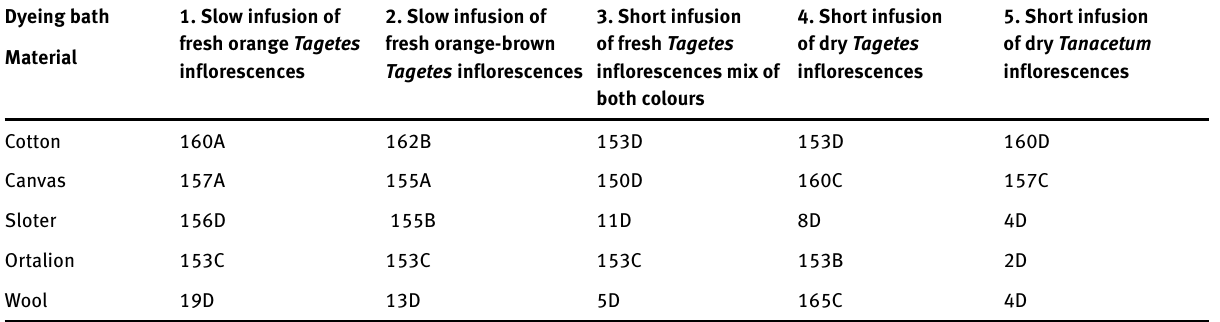
Table 4 : RHS colours of samples measured 60 days after dyeing Dyeing